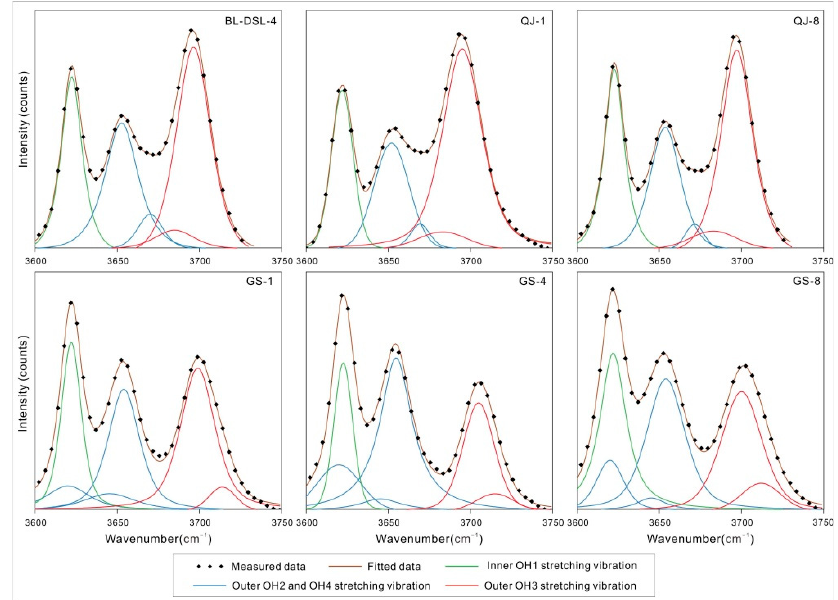
Figure 3. MIR spectral component analysis of the OH stretching region.